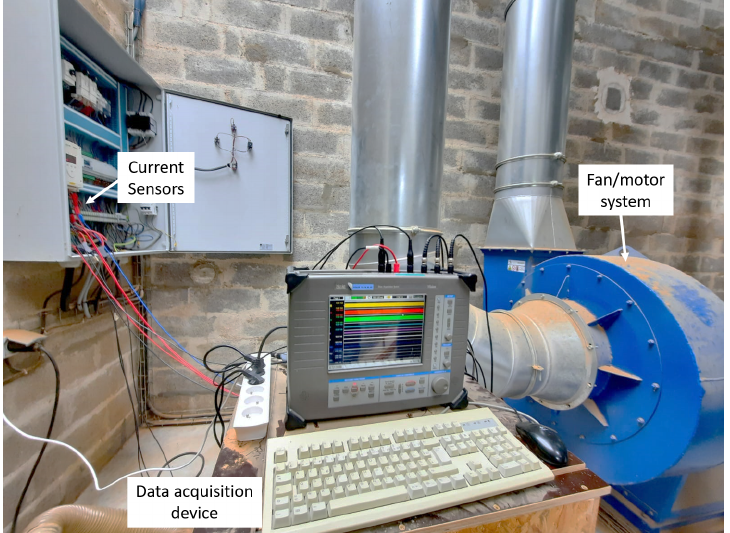
Figure 8. The data acquisition system.